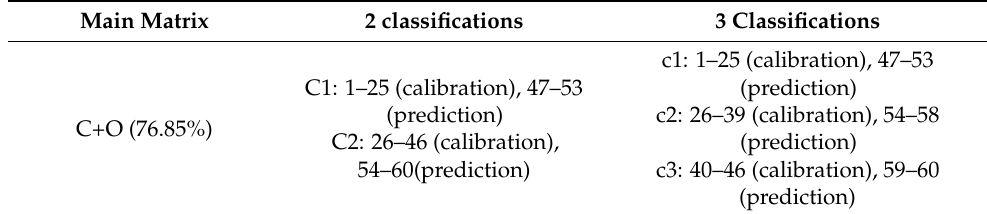
Table 1. Classification results of biochar samples.